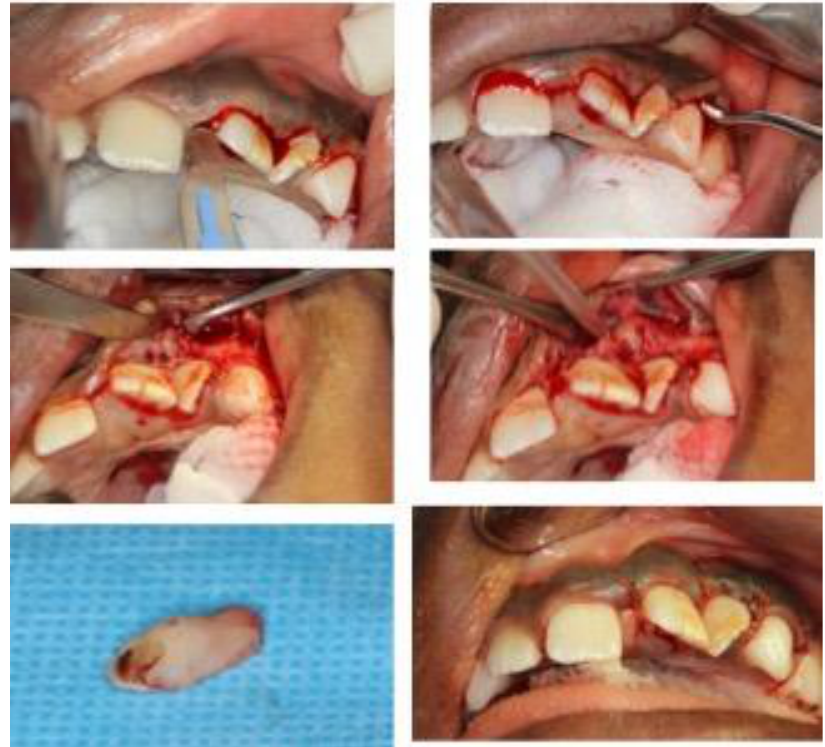
Figure 3. Intra-operative pictures for the surgical removal of the “extra” tooth. Notice the morphology of removed tooth that highly resembles a primary incisor with a mild crown fracture and some apical resorption.